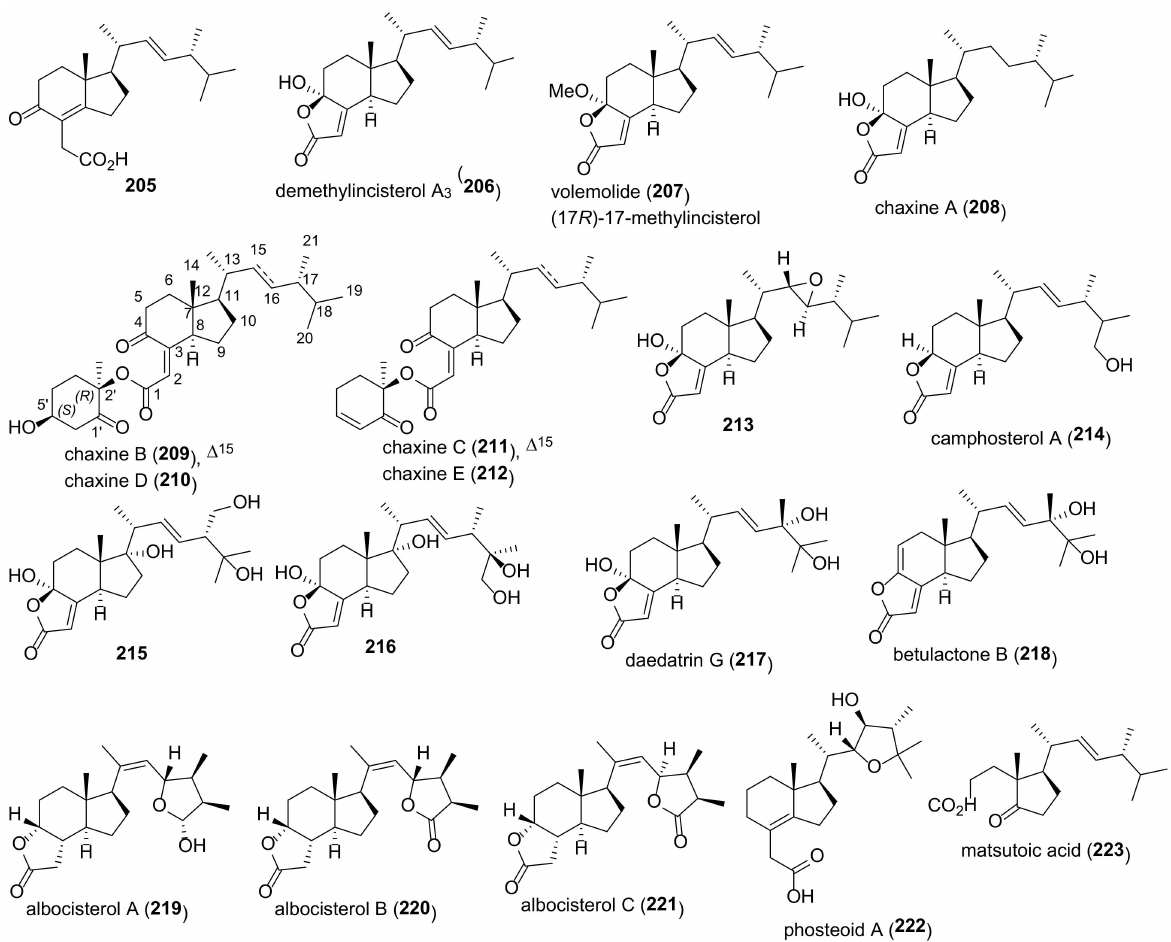
Figure 22. Structures of degraded